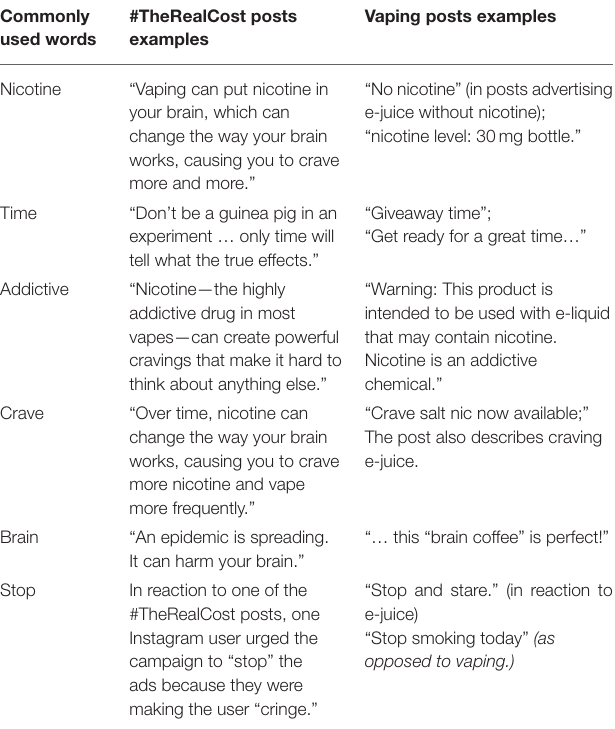
TABLE 2 | Commonly used words in captions of Instagram posts related to vaping from the March 2019 sample ( N = 21,906) and the U.S. Federal Food and Drug Administration anti-vaping campaign “The Real Cost” ( N = 46). ( Figure 3 ). The themes in the May 2018 sample were very similar, except for the absence of Pod system-related and nicotine salts- related topics. LDA detected only pro-vaping topics. No anti- vaping topics were detected by LDA, presumably due to the relatively small number of anti-vaping posts ( N = 46, Figure 3 ) identified in the #TheRealCost sample